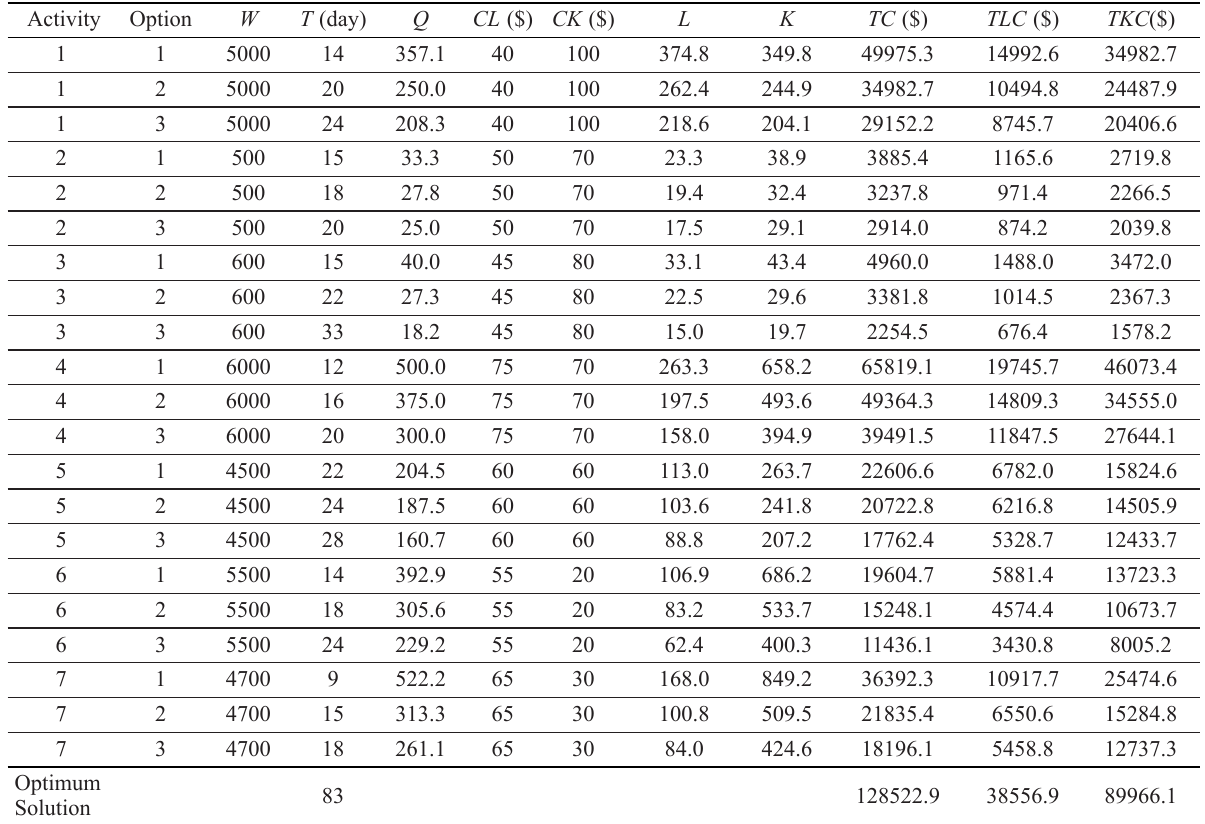
Table 2. The case project information Activity